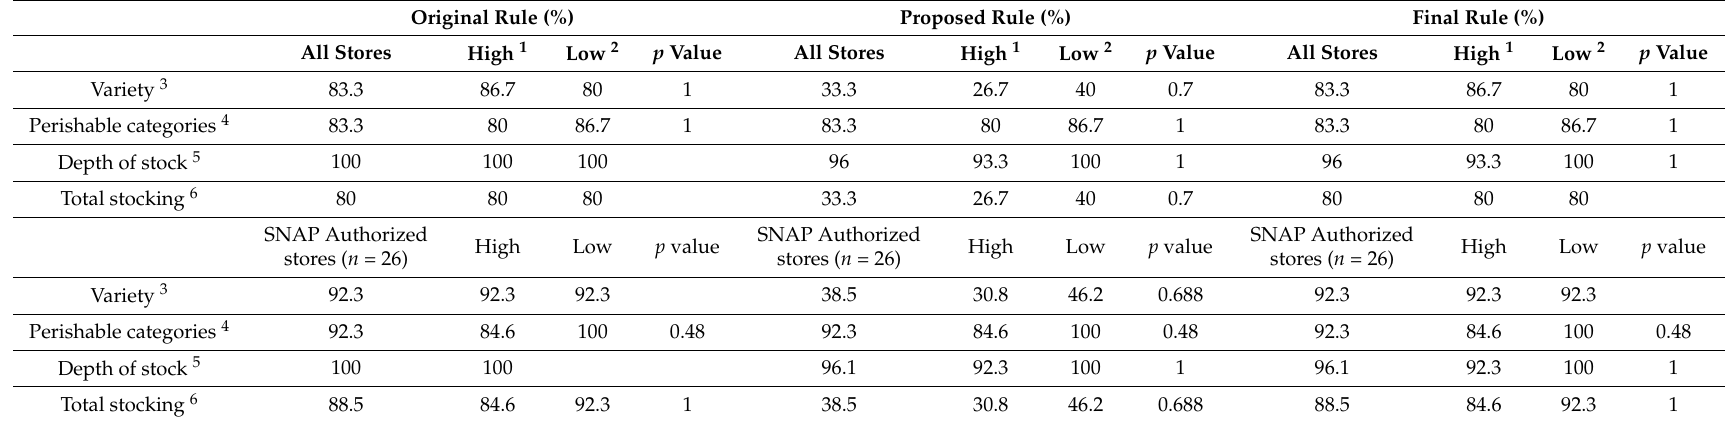
Table 3. Proportion of stores meeting the different versions of variety, perishable categories, depth of stock, and total stocking requirements ( n = 30). Original Rule (%) Proposed Rule (%) Final Rule (%) All Stores High 1 Low 2 p Value All Stores High